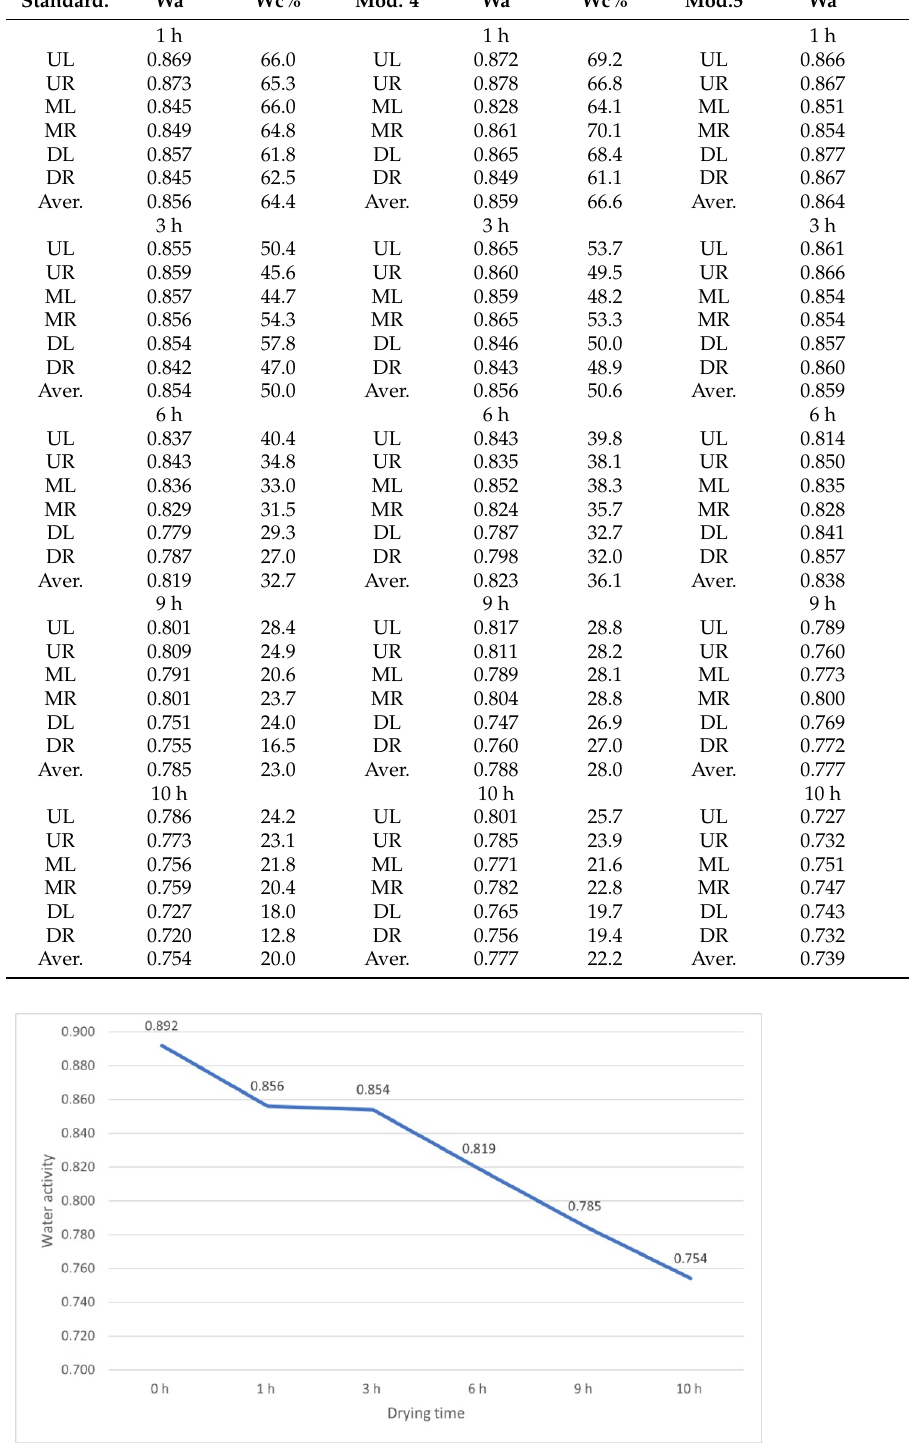
Figure 20. Drying curve—mean Wa in the chamber 1.